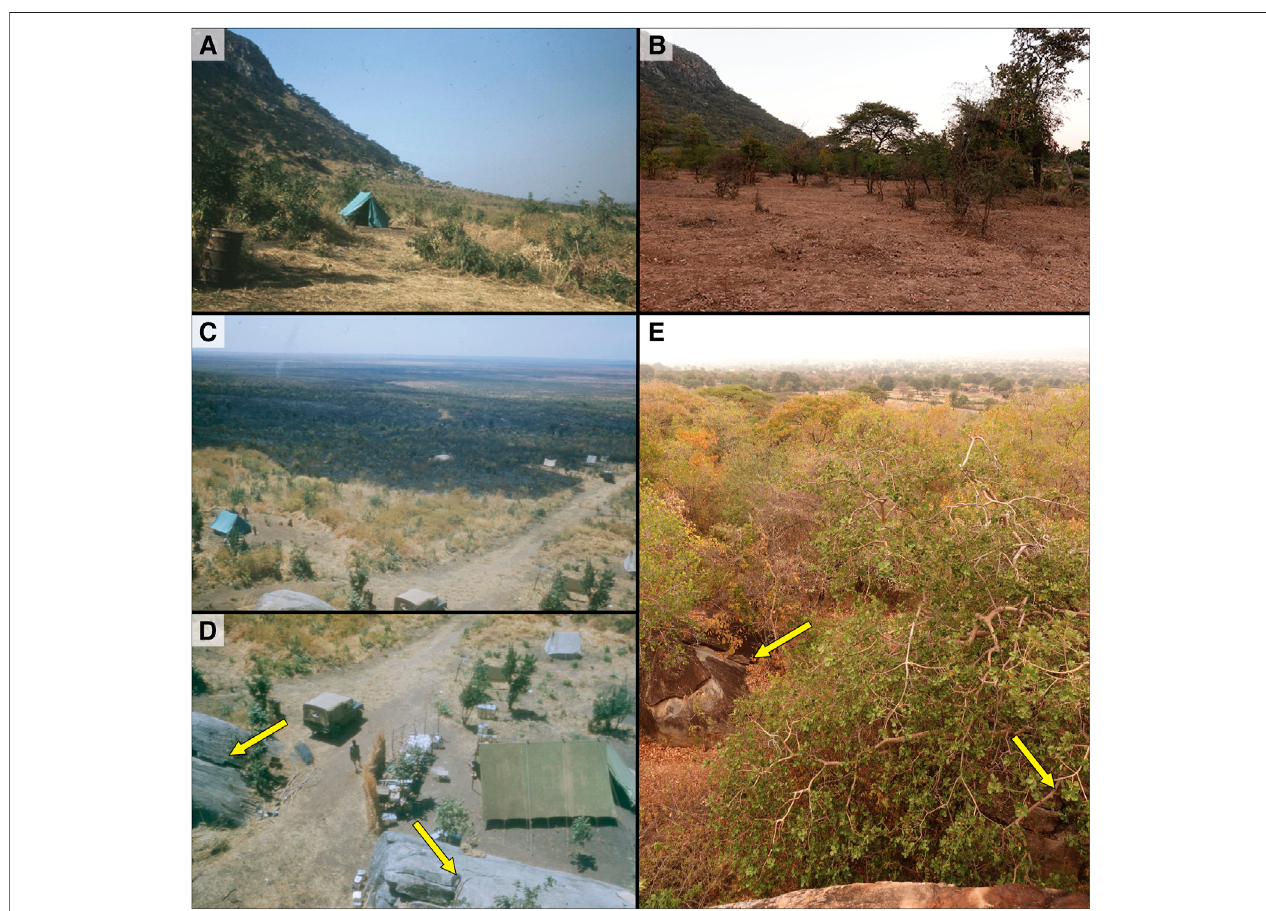
FIGURE 3 | Comparison of images taken during the 1956 Inkeep excavations (A,C,D) and 2019 Ranhorn excavations (B,E) showing changes at a landscape scale. (A , B) Photographs taken from the lowlands facing north. Note the shift from a grassland dominated vegetation to wooded, as well as the disappearance of the yellow regosol in favor of the red paleosol. (C – E) Photographs taken from the front boulder of the Kisese II facing south towards the Maasai Steppe. Arrows indicate distinctive rock features visible in the historic and modern photos. Here again the vegetation shift from savanna grassland to woods is evident as is the change in topsoil. Note the large burned patch of grass in (C) portraying slash and burn farming technique in use in the 1950s.